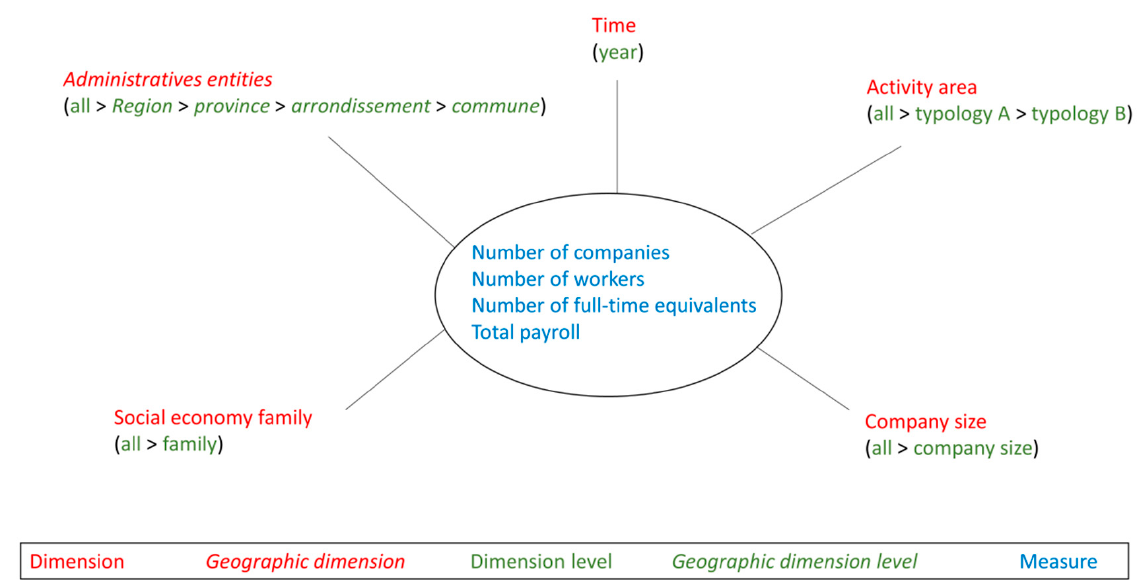
Figure 5. A data cube star schema.